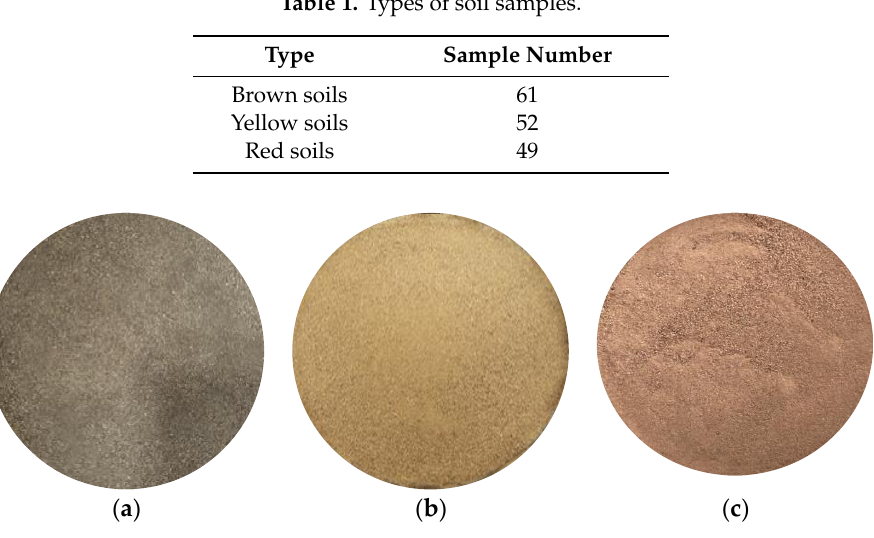
Figure 2. Red, green, and blue (RGB) images of ( a ) Brown, ( b ) Yellow, and ( c ) Red soils after No. 40 sieve